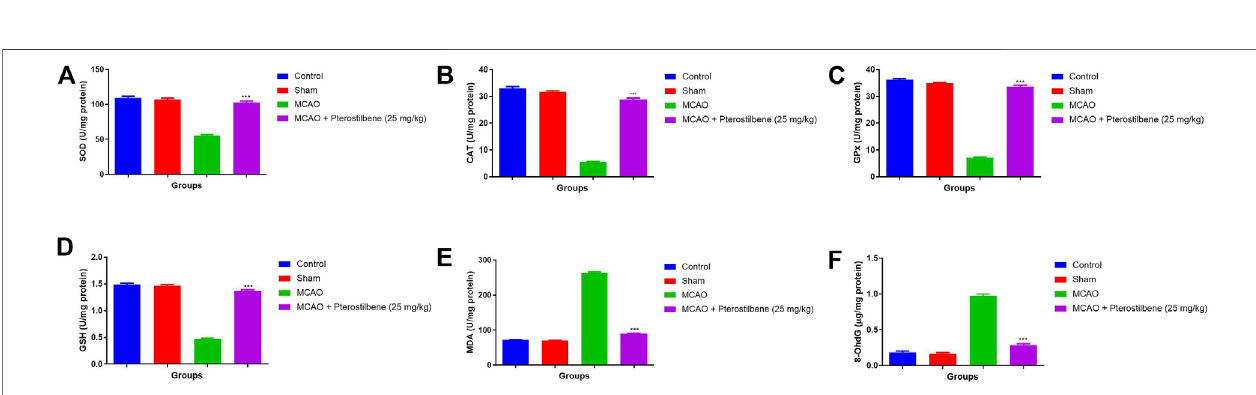
FIGURE 9 | showed the antioxidant parameters of among experimental groups. (A) SOD, (B) CAT, (C) GPx, (D) GSH, (E) MDA and (F) 8-OhdG. Values are expressed as mean ± SEM. The t -test was used for the signi fi cant difference between groups: * p < 0.05, ** p < 0.01, *** p < 0.005. NS, non-signi fi cant.